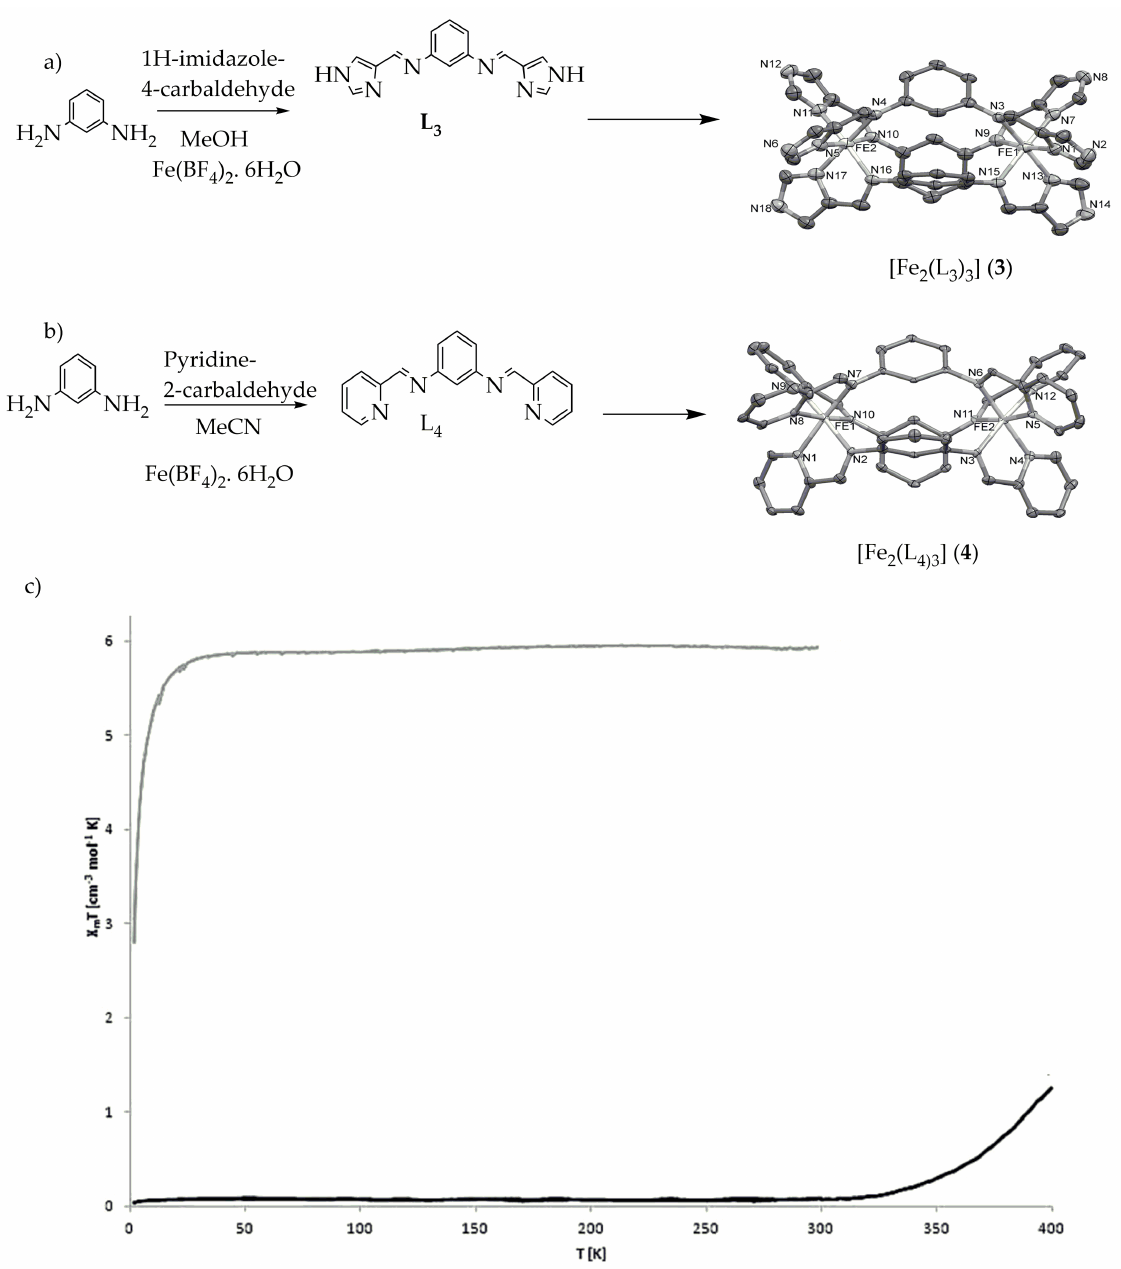
Figure 5. ( b ) [Fe 2 (L 4 ) 3 ] ( 4 ) [L 4 = N , N (cid:48) -bis(pyridin-2-ylmethylene)benzene-1,3-diamine] ( c ) Magnetic behavior of complexes ( 3 ) blue line and ( 4 ) red line complexes as χ M T vs. T plot. Reproduced with permission from [67]; Published by Wiley,